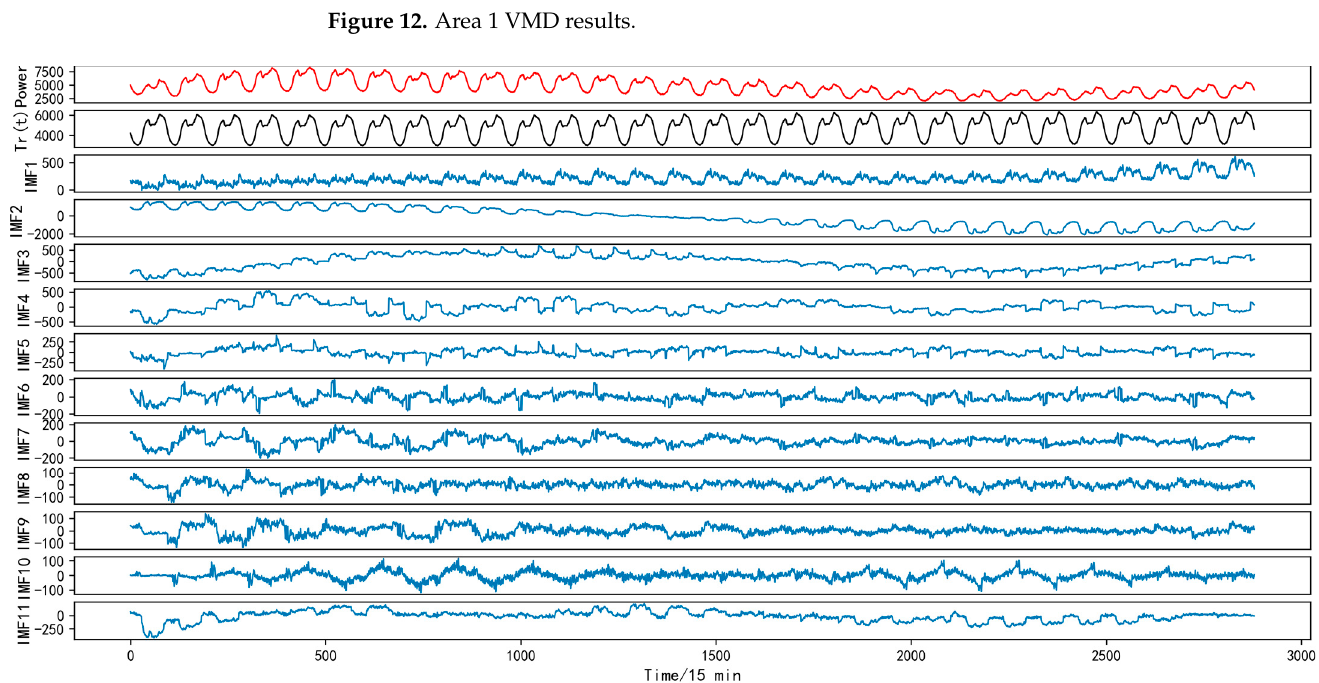
Figure 13. Area 2 VMD results.